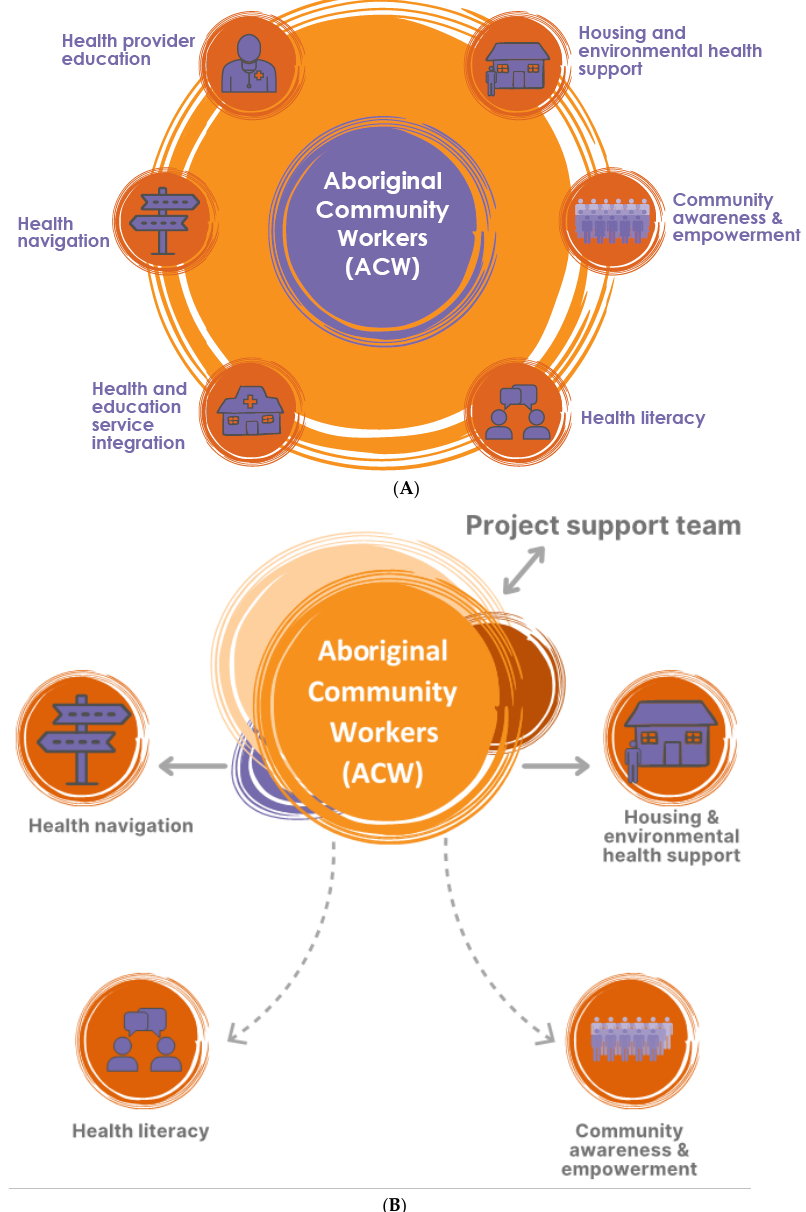
Figure 1. ( A ) Activity domains of the outreach-based support model as originally conceived; ( B ) Actual activity domains best addressed during study implementation (solid arrows: major activi- ties; dotted arrows: minor activities).